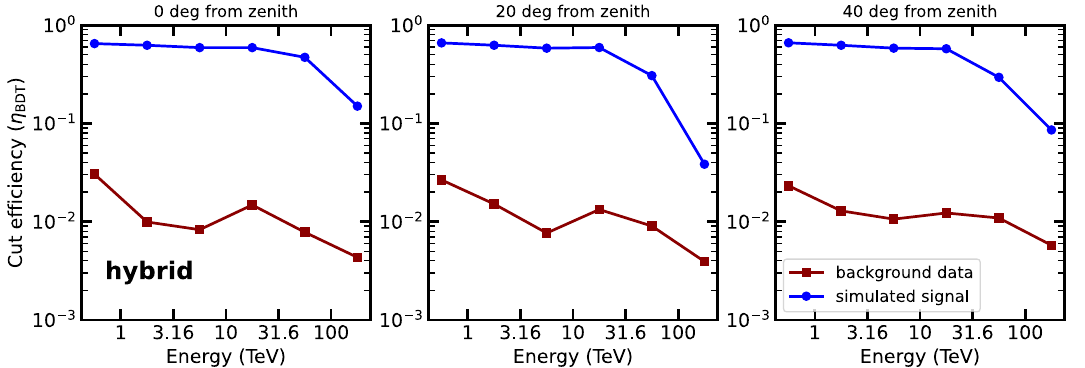
p.e. for the hard cuts). The resulting efficiencies are shown for different energies and zenith ranges in Figs. 6 ( stereo reconstruction) and 7 ( hybrid reconstruction). Note that the cuts used in the hybrid case, so-called standard-hybrid cuts, are different from the stereo ones in terms of thresholds, but are optimized for the same science case: a Crab Nebula-like